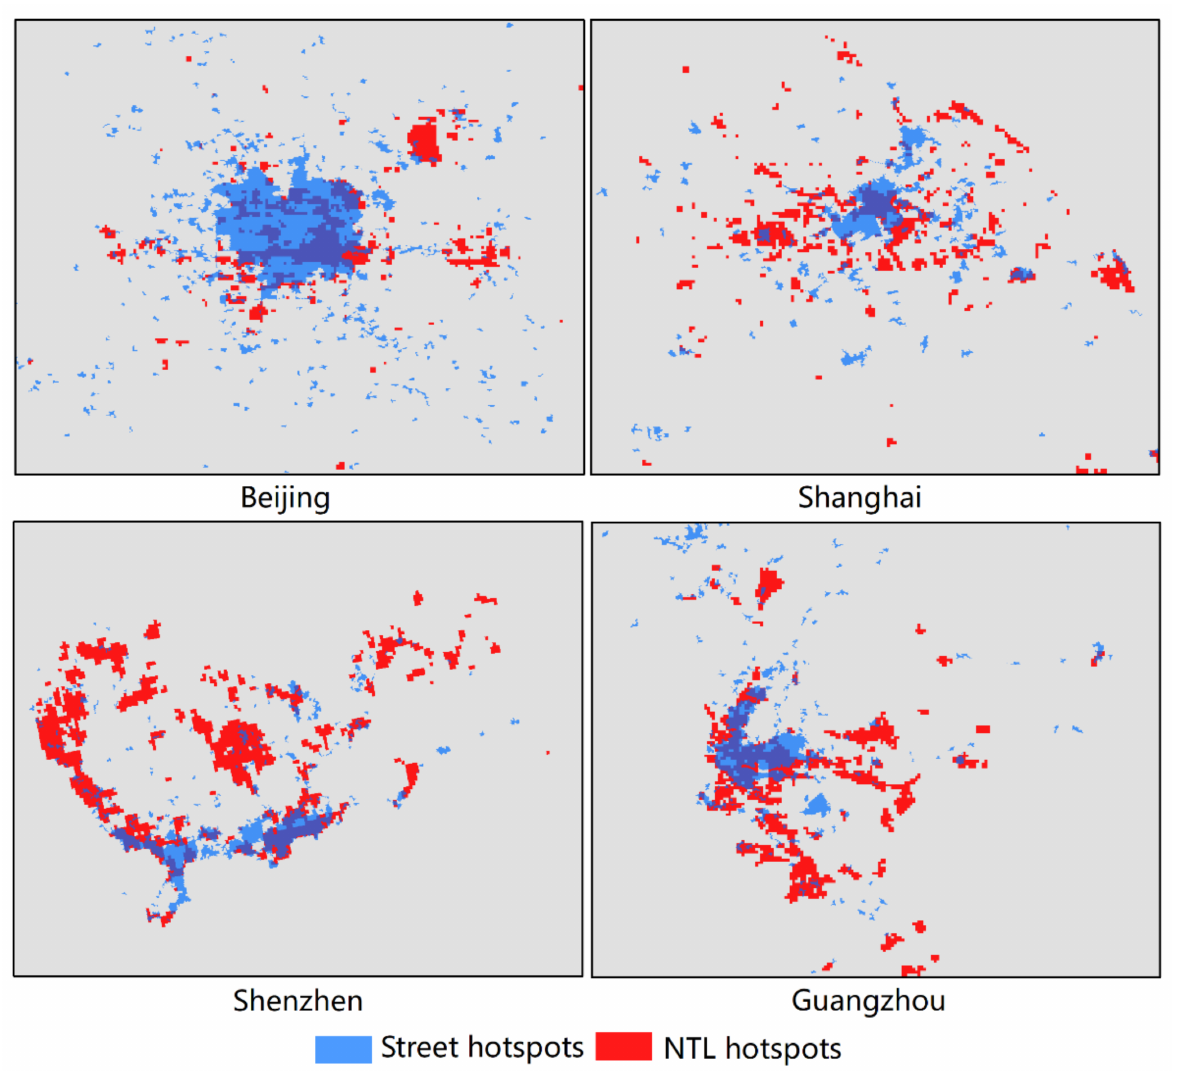
Figure 5. (Color online) Comparison between two types of urban hotspots in four Chinese first-tier